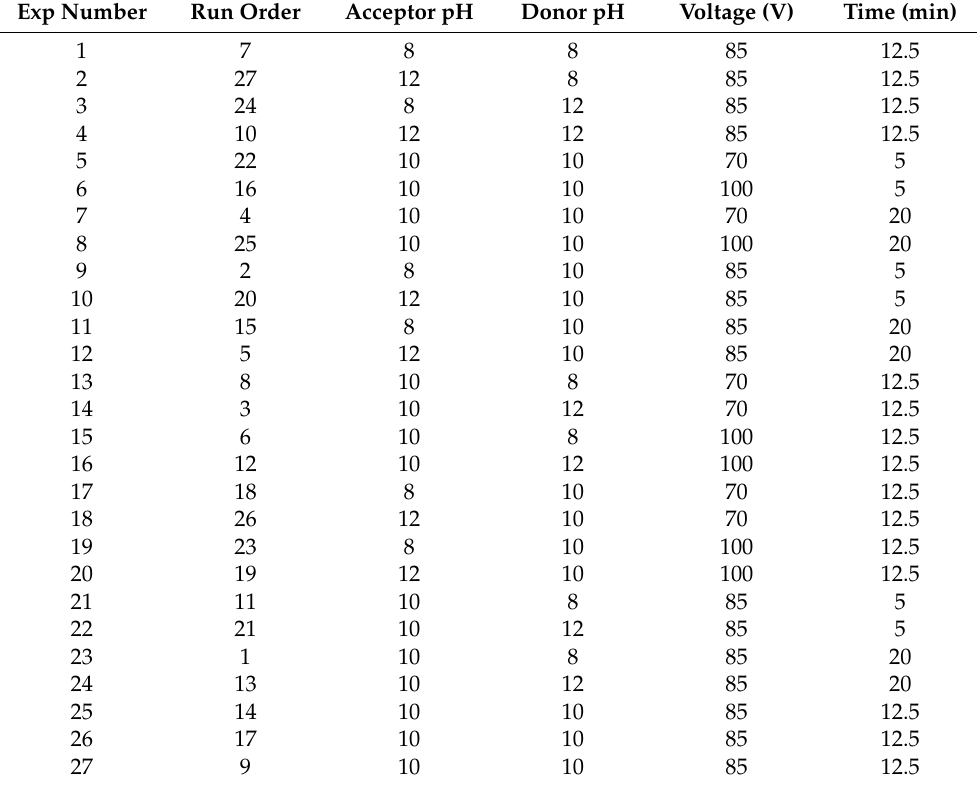
Table 1. Box–Behnken input matrix employed for the experimental